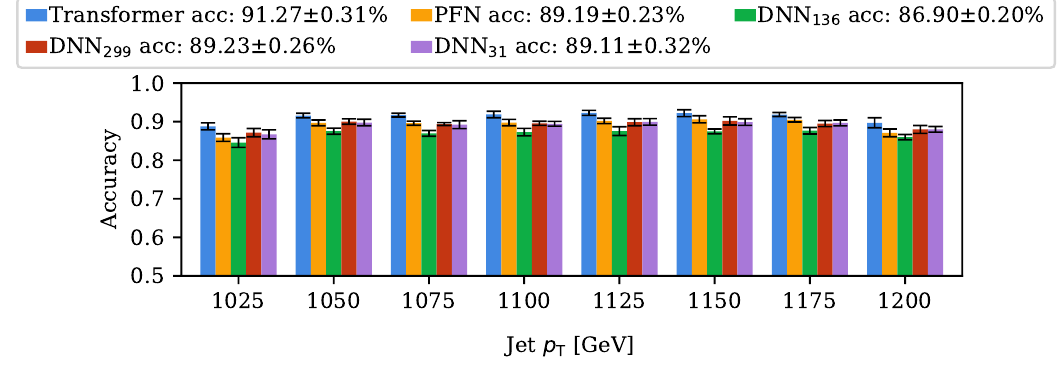
Figure 9 . Mean 10-fold accuracy and statistical uncertainty of the various networks predictions for jets within ranges of jet p T . The jets are binned according to their p T in intervals of 25 GeV. The x-axis labels correspond to the upper bound of the intervals.